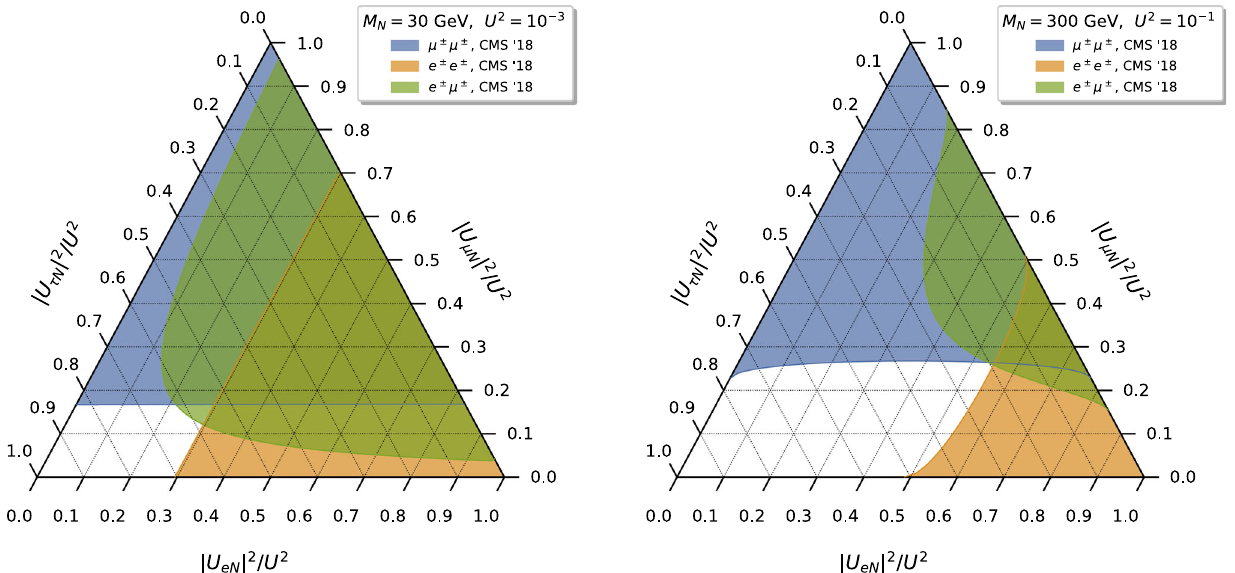
Fig. 4 Combination of several bounds in a general mixing pattern for two benchmark points of mass and total mixing U 2 . Each bound corre- spond to the latest SS dilepton searches by CMS (Table 1), which were